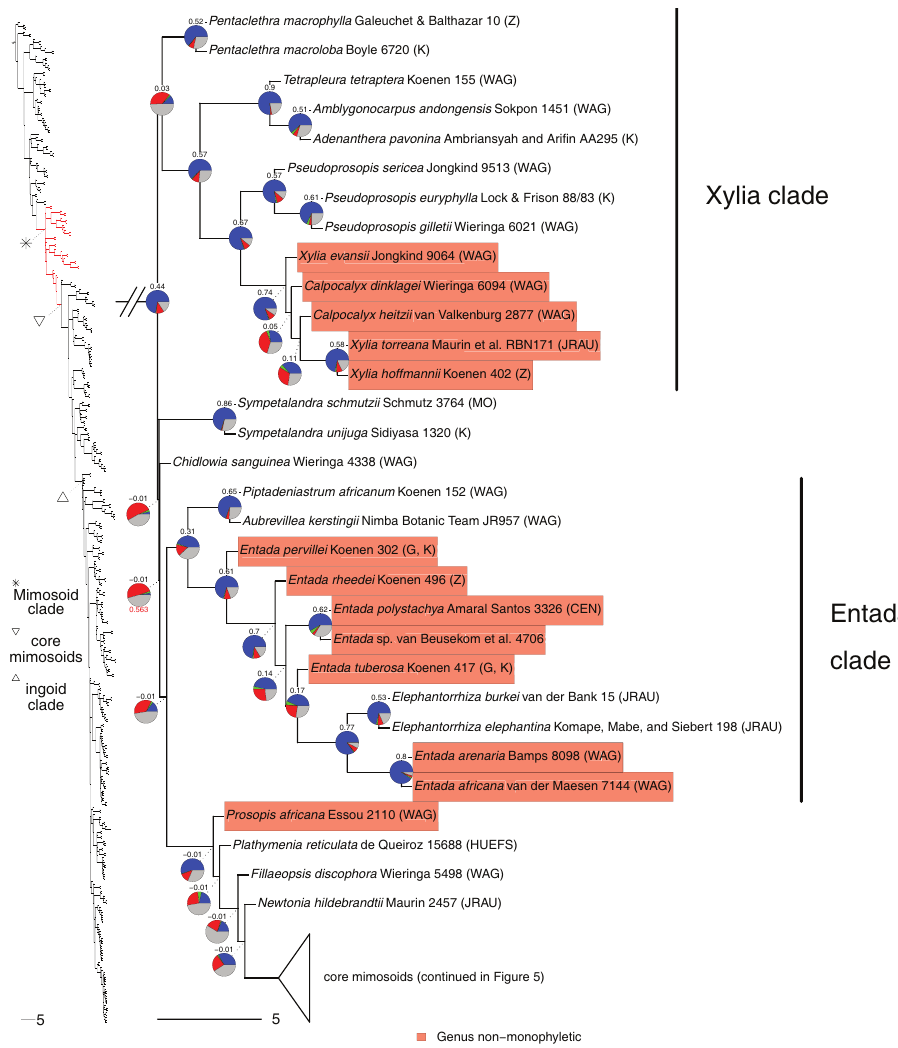
Figure 4. Phylogeny of Caesalpinioideae (continued). See Fig. 2 for